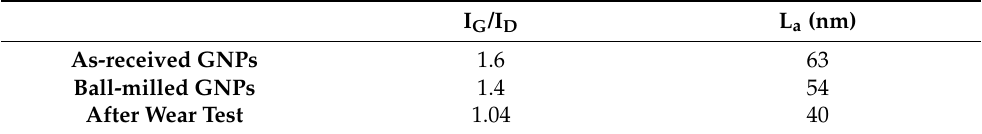
Figure 11. The Raman spectrum of the worn surface of nanolubricants with neat oil and 0.30 vol.% nanolubricants. Table 2. In-plane crystallite size, L a , of GNPs calculated by using the Raman spectrum before and after the wear